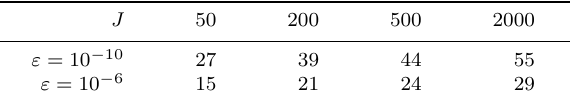
Table 6. Number of iterations on J . Neumann problem, the 5-point solver, 9-point